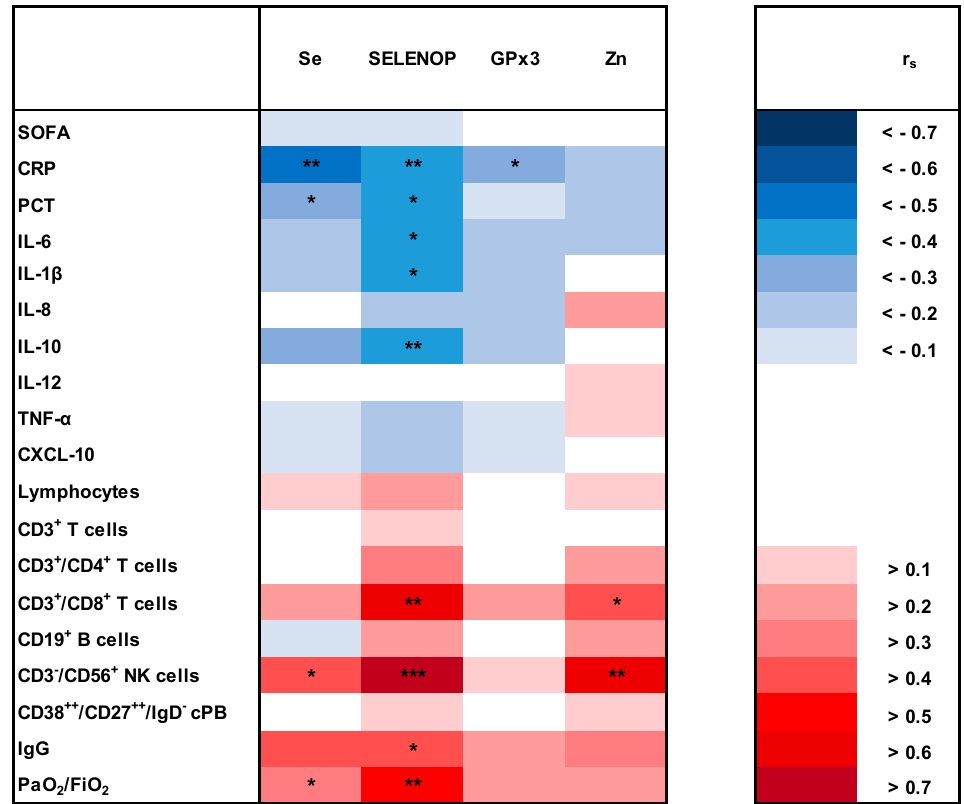
Figure 4. Correlation matrix of nutritional status and inflammation. Red colors indicate a positive and blue colors a negative correlation coefficient (r s ). p < 0.05 (*), p < 0.01 (**), p < 0.001 (***). CPB, circulating plasmablasts; CRP, C-reactive protein; Ig, immunoglobulin; IL, interleukin; GPx3, glutathione peroxidase 3; NK, natural killer; PCT, procalcitonin; Se, selenium; SELENOP, selenoprotein P; SOFA, sequential organ failure assessment score; TNF, tumor necrosis factor; Zn, zinc. In comparison to patients with a fatal outcome ( n = 8), survivors ( n = 14) significantly responded to supplementation with an increase in Se ( p = 0.008), SELENOP ( p = 0.004), GPx3 ( p = 0.039) and Zn levels ( p = 0.020) over the course of the ICU stay (Figure 5). Decedents had a median ICU course of 17.5 days (12–22), whereas patients with a favorable outcome were treated for significantly longer (40 days, 20–44; p = 0.025). Despite a similar supplementation regimen, survivors tended to have higher Se levels after 10 to 14 days of